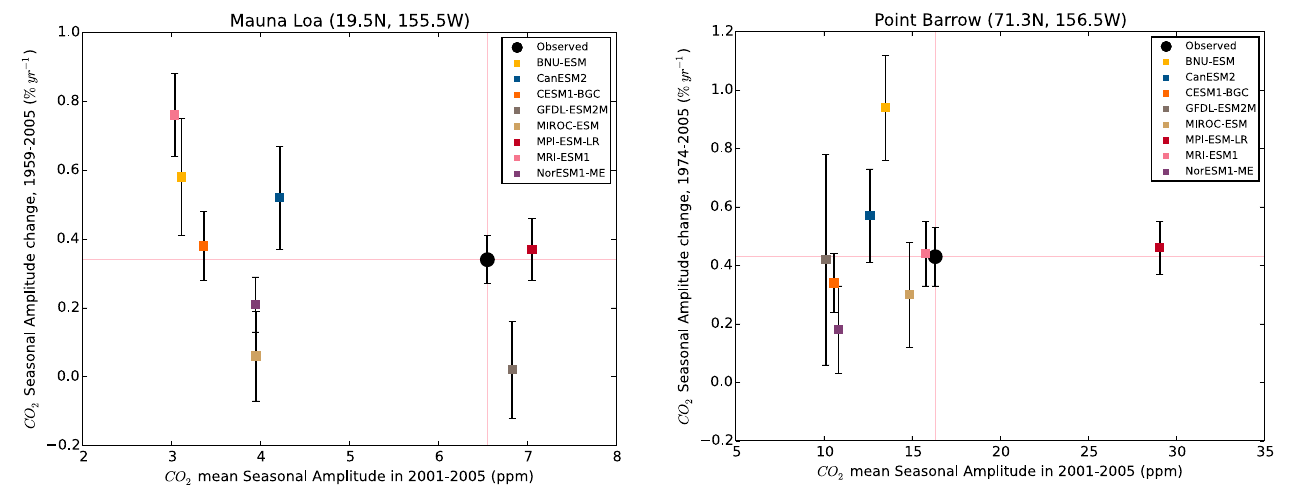
Figure 9. CO 2 mean seasonal amplitude (ppm) during 2001–2005 and increase in CO 2 seasonal amplitude at Mauna Loa during 1959–2005 (%yr − 1 , linear trend) from eight CMIP5 models and observation. The big black circle represent surface CO 2 observa- tion at Mauna Loa, Hawaii (19.5 ◦ N, 155.6 ◦ W; 3400m above sea level). The colored squares represent the 700hPa (close to the alti- tude of Mauna Loa station surface) CO 2 output at the original grid that covers Mauna Loa from each of the eight models. Error bars indicate ± 1 standard error in the trend calculation. Compared to the surface observation, only MPI-ESM-LR and GFDL-ESM2M over- estimate CO 2 mean seasonal amplitude at Mauna Loa, while the other models underestimate this amplitude. Models split between overestimating and underestimating the CO 2 seasonal amplitude in- crease at Mauna Loa.